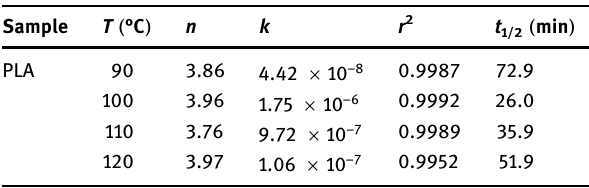
Table 3: Properties and parameters of isothermal